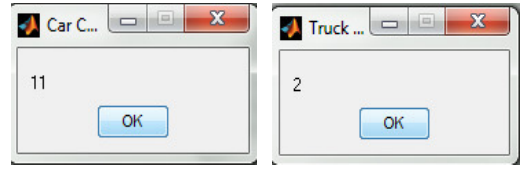
Figure 32: Car & Truck Counts of the ROI